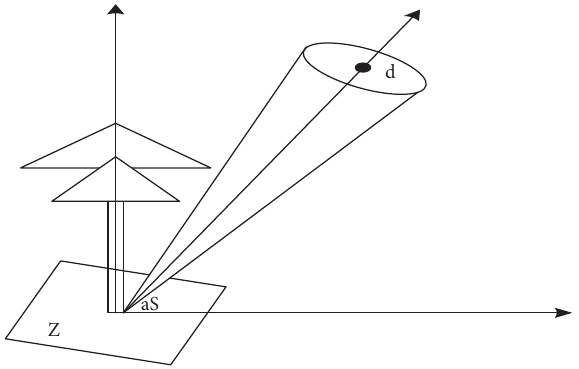
Figure 2: Angle of greenhouse gardening fruit